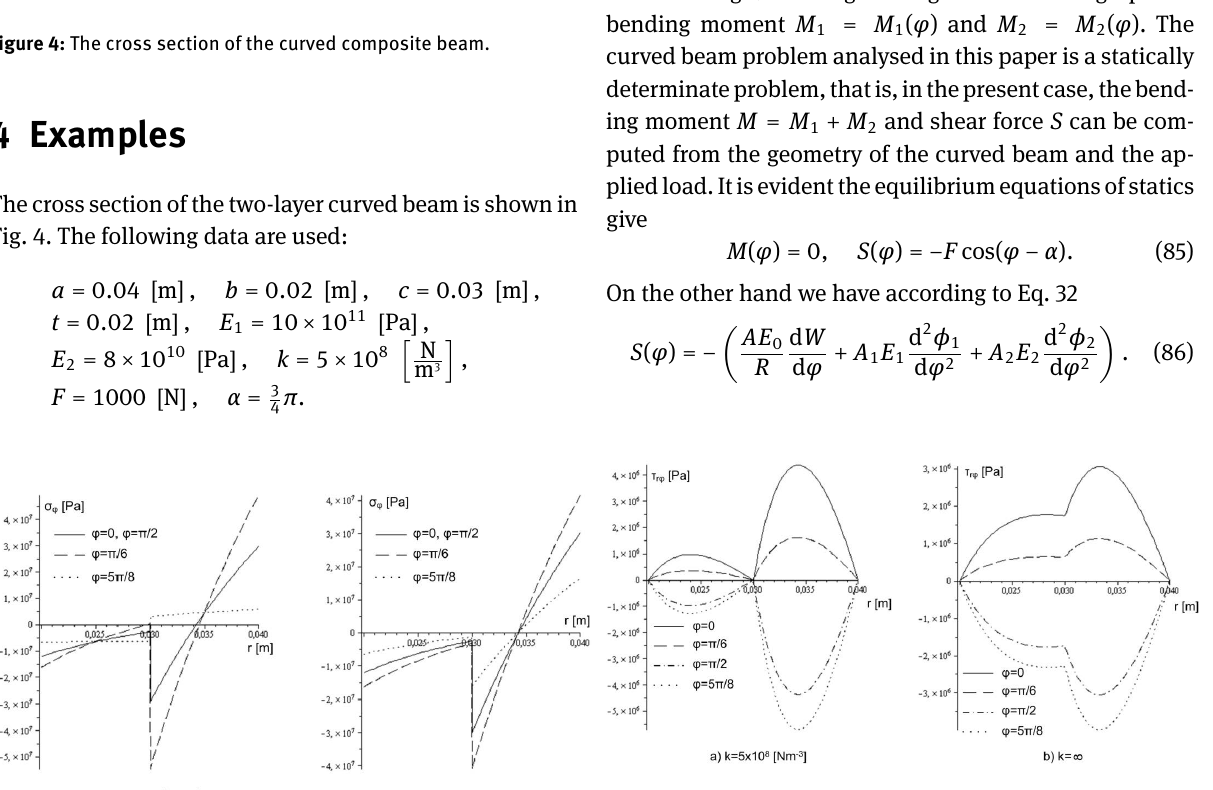
Figure 5: Plots σ φ for Example 1.